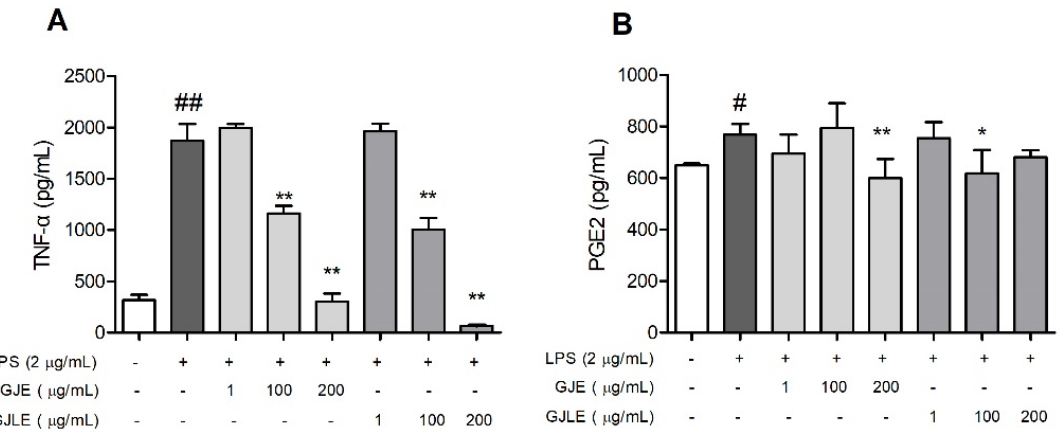
Figure 5. Effects of G. jasminoides ( A ) and G. jasminoides f. longicarpa ( B ) flower essential oils on the expression of TNF- α and PGE2 in MH-S cells. Values represent the mean ± SD from four independent experiments, * p < 0.05 and ** p < 0.01 vs. the control treatment group with LPS; # means p < 0.05 and ## means p < 0.01 vs. the control treatment group without LPS. One-way ANOVA was used, and Duncan test was used for post hoc analysis.